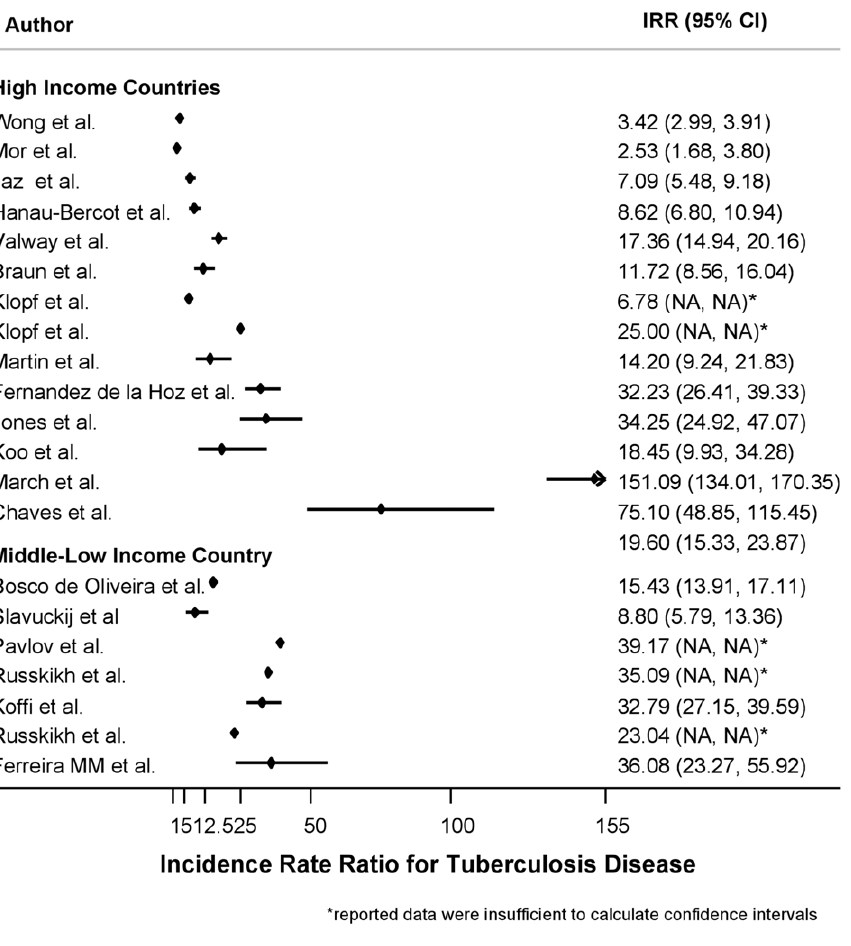
Figure 3. Forest plot showing the study-specific estimates of the IRR for tuberculosis in prisons as compared to the corresponding general populations, by income area according to the World Bank classification. Source: [12]. NA, not applicable.